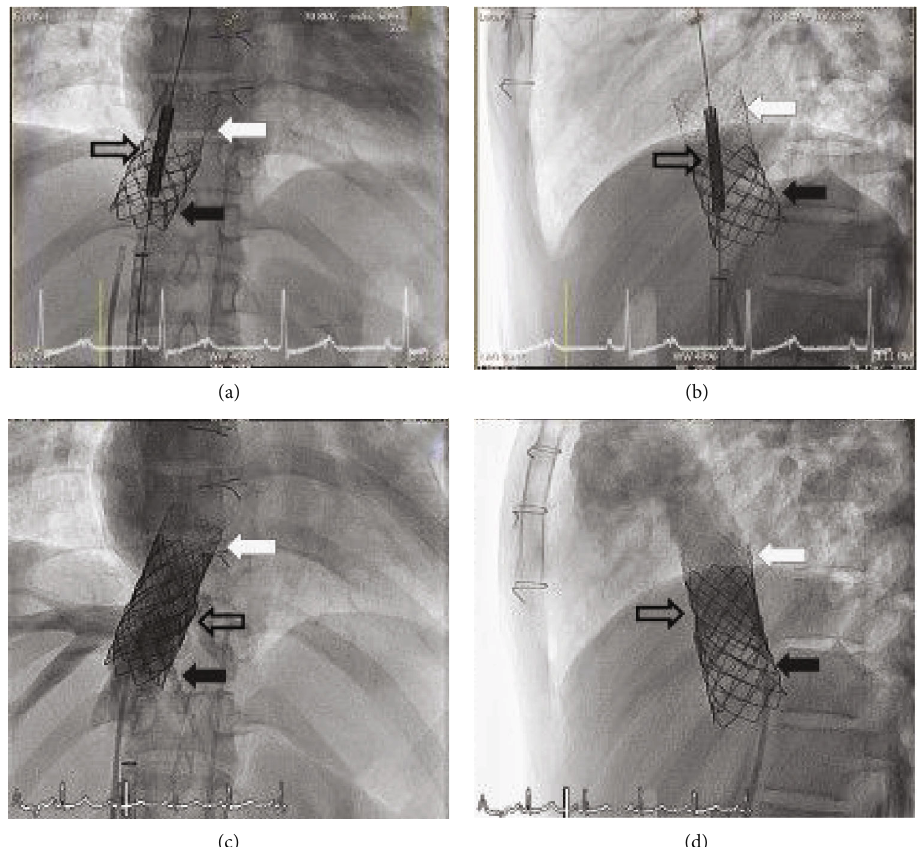
Figure 16: A second bare stent was then applied over the overlapping section of the fi rst bare stent and the covered stent in order to stabilize both the structure of the combination stent and the patency of the a ff ected vasculature ((a) anterior and (b) lateral views on angiography). Postprocedural angiogram showed the second bare stent in place with good blood fl ow in the hepatic veins ((c) anterior and (d) lateral views on angiography). No contrast was observed fi lling in the pulmonary vein. The black arrow, white arrow, and black outline arrow indicate the position of the fi rst bare stent, the covered stent, and the second bare stent, respectively.